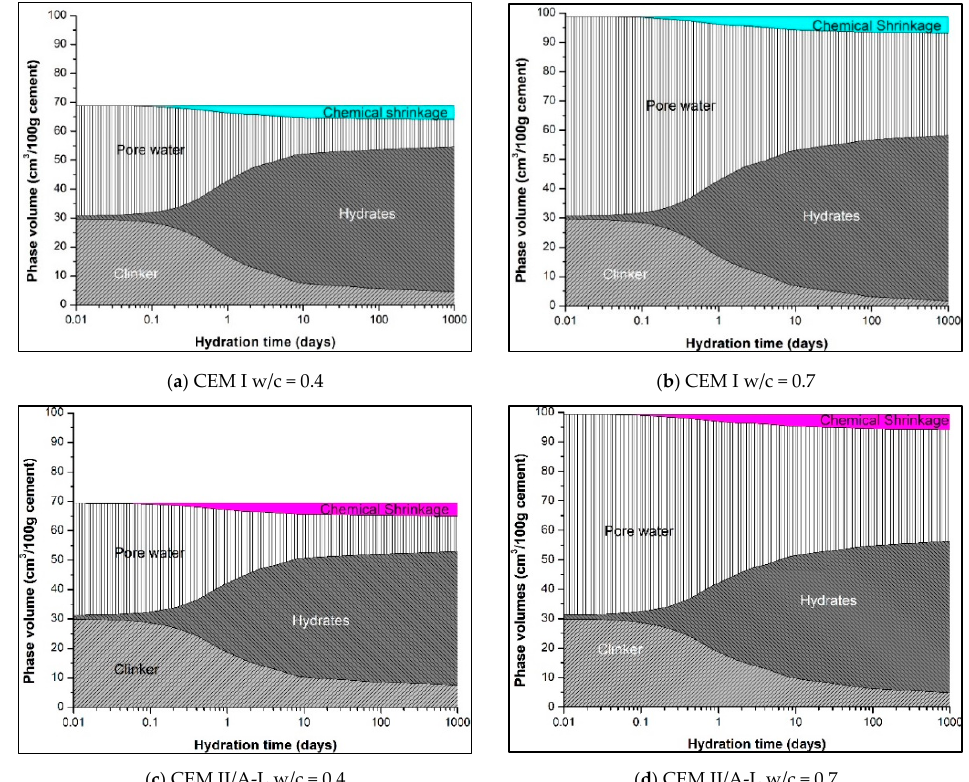
Buildings 2022 , 12 , x FOR PEER REVIEW Figure 2. Predicted phase assemblages for the two cements. Figure 2. Predicted phase assemblages for the two cements.